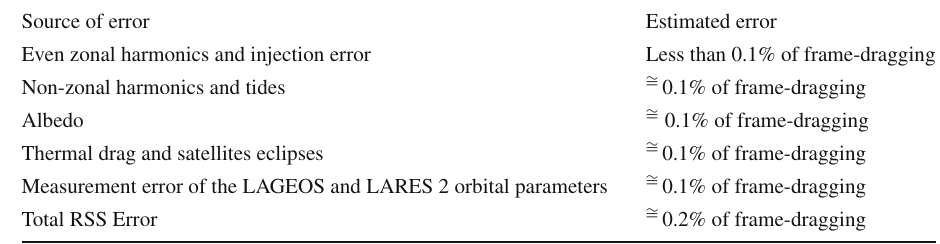
Table 3 Relative errors in the LARES 2 measurement of frame-dragging